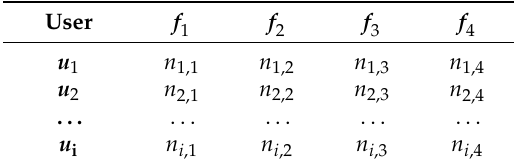
Table 1. User’s behavior-matrix.